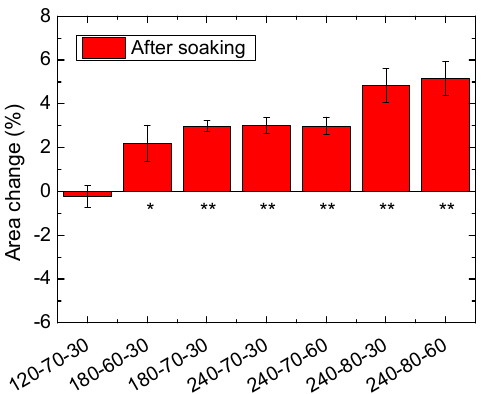
Figure 5. Percentage change of the areas of the electrospun PAN nanofiber mats after exposure to pure water. Statistical significance is depicted by * ( p < 0.05) or ** ( p < 0.01), respectively.